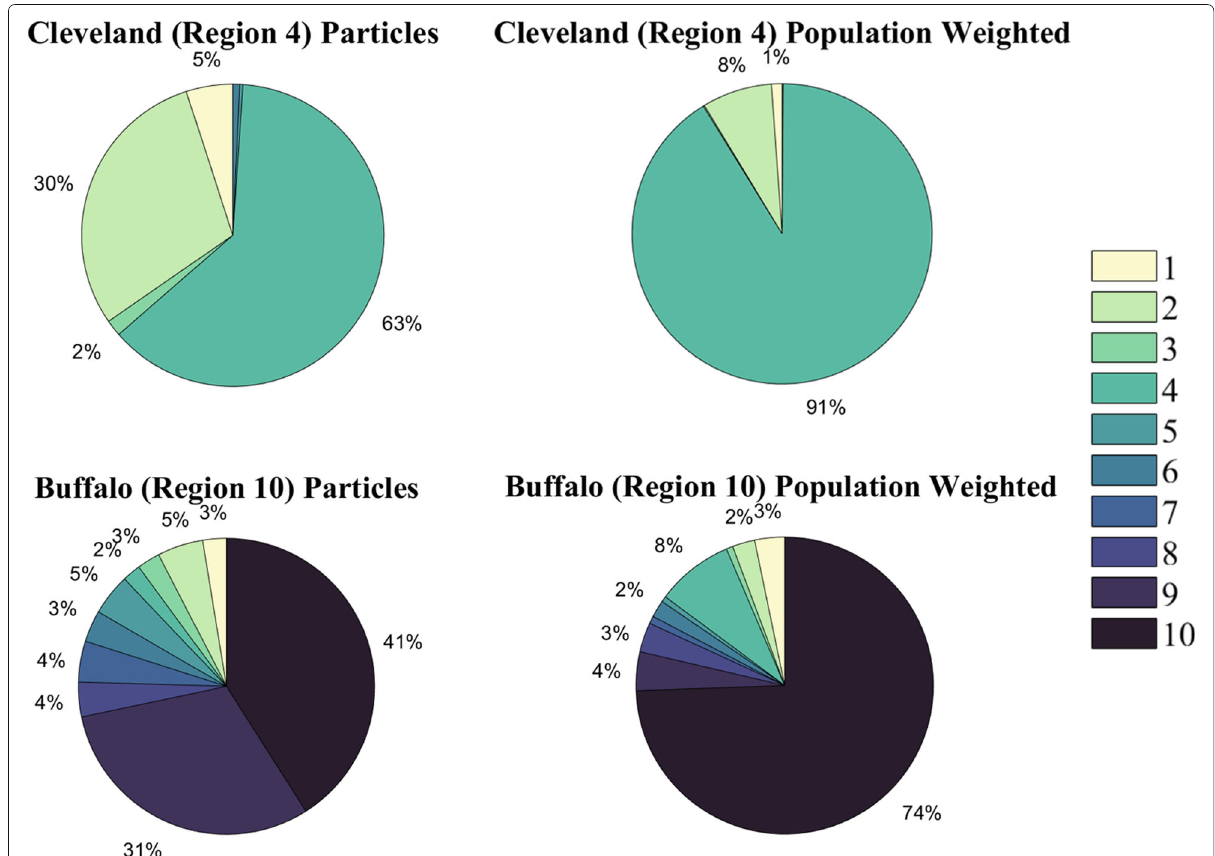
Fig. 7 Origins of beached particles in Cleveland (Region 4) and Buffalo (Region 10). Left: percentages by particle count, Right: percentages weighted by population at particle origin point